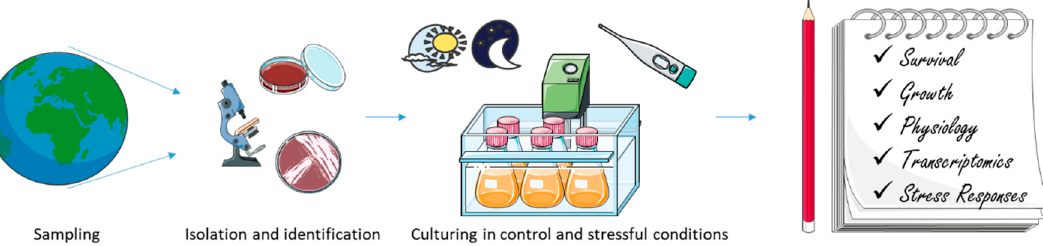
Figure 2. The figure summarizes the most common pipeline used in order to study microbial responses to main environmental stressors (e.g., low temperature and high light).